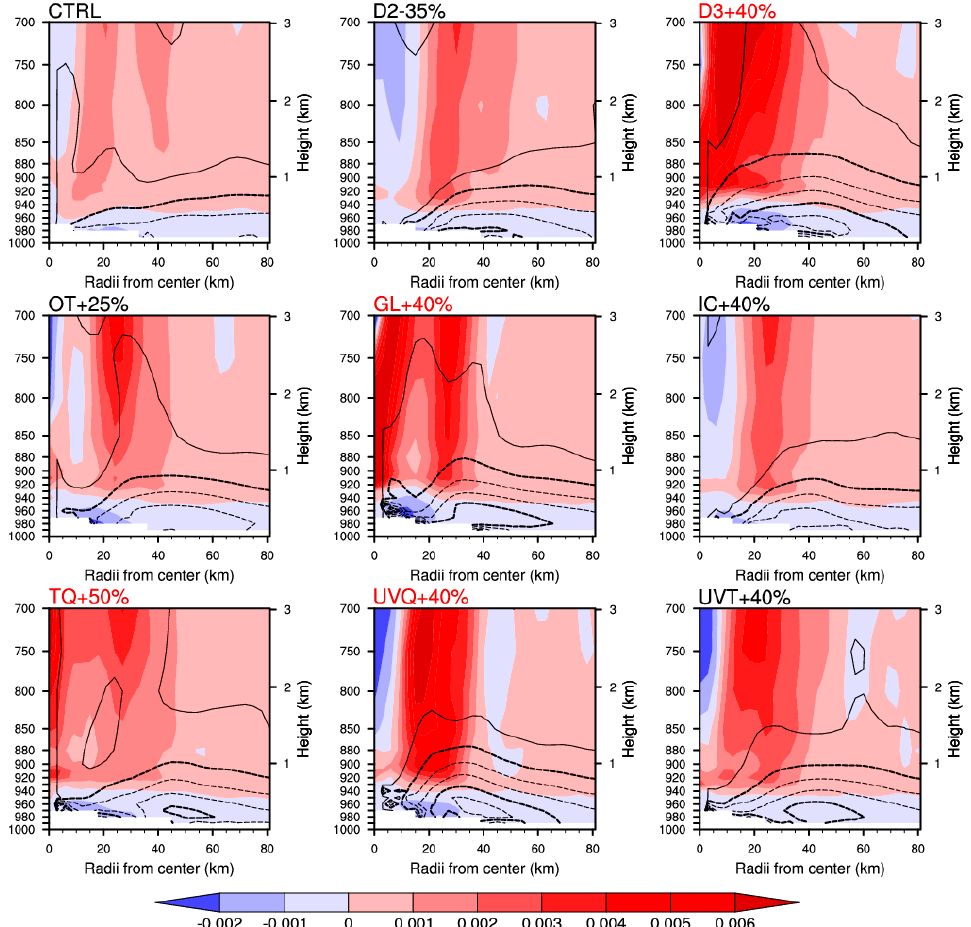
Figure 8. Radius–height cross-section of time-averaged (from 09 UTC Sept. 26 to 00 UTC Sept. 27) latent heating (shaded; J kg − 1 s − 1 ) and isopleths of water vapor convergence (measured by radial wind component times water vapor mixing ratio; m s − 1 ). The contour interval is 6 × 10 − 2 m s − 1 . Contours with values 6 × 10 − 2 m s − 1 and 2.4 × 10 − 1 m s − 1 are highlighted as thick curves.